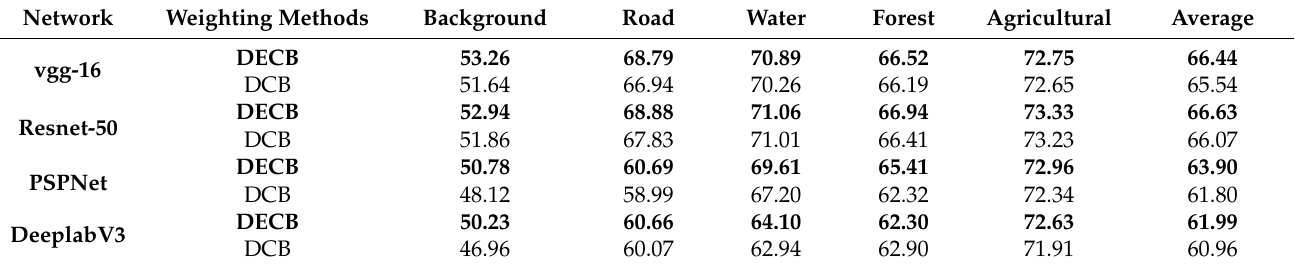
Table 7. The IoU results for different networks in LoveDA-r-road